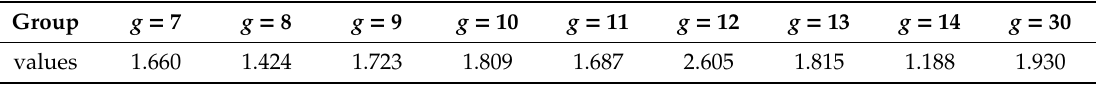
(cid:16) (cid:17) N 6,2 , ν g , g = 1, ... ,30 with absolute values greater than k = 1